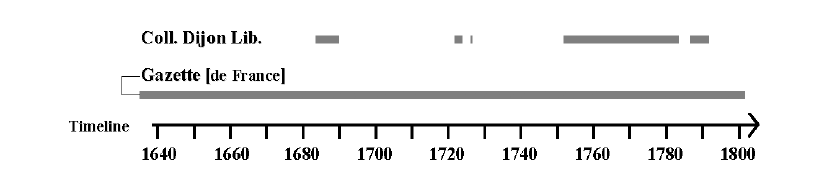
Fig. 5. Time-coverage of the Gazette de France collection perused by Alexis Perrey (1848) compared with the collection actually available.